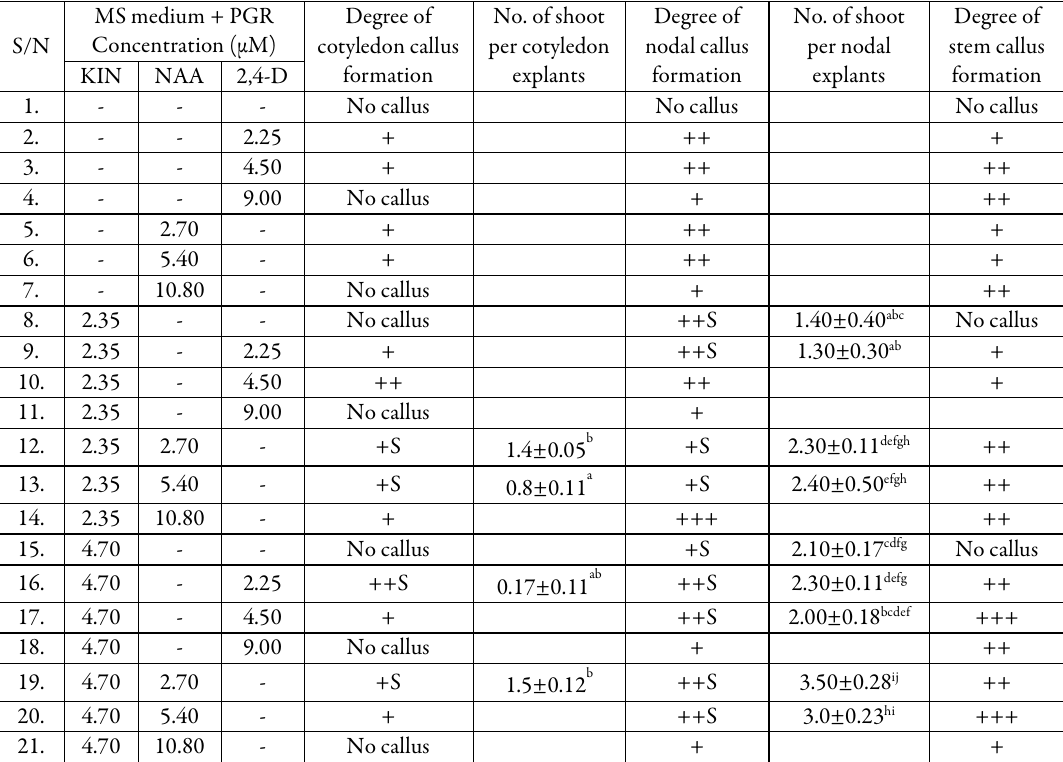
Table 4. The effects of various concentrations of NAA, 2, 4-D alone or each separately combined with kinetin on caulogenesis from stem, cotyledon and nodal explants of E.